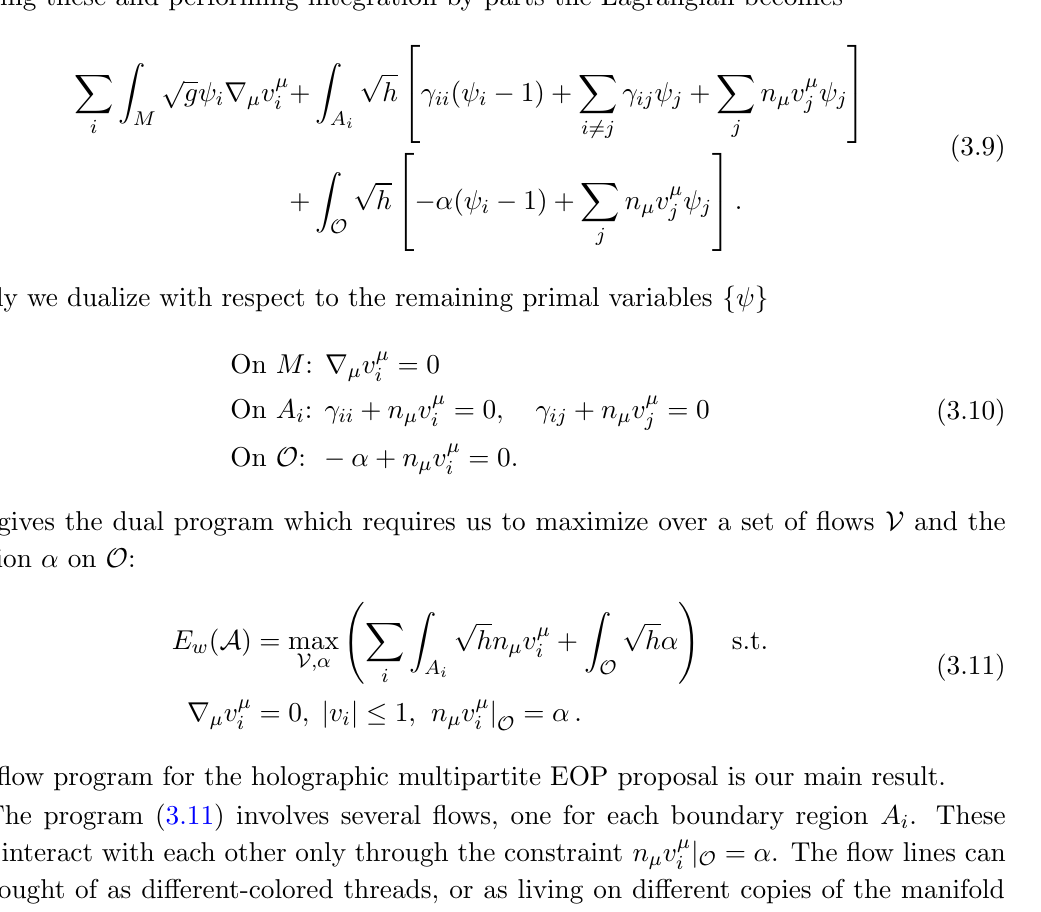
Figure 14 . An example of a maximal (cid:13)ow con(cid:12)guration local (cid:13)ux on which we call (cid:11) is the same for all three of the (cid:13)ows. In the example each O